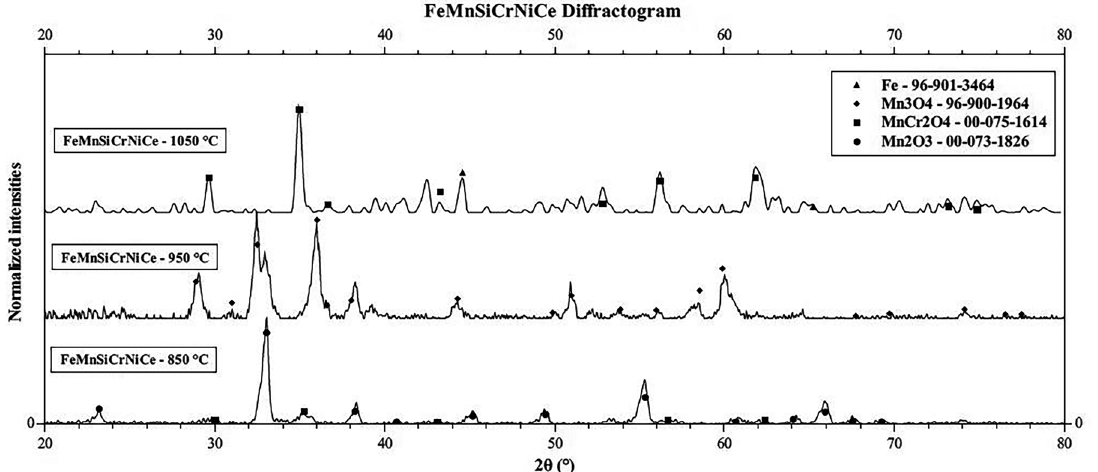
Figure 7. XRD oxidized layer diffractogram after 850, 950 and 1050 ºC tests - FeMnSiCrNiCe.